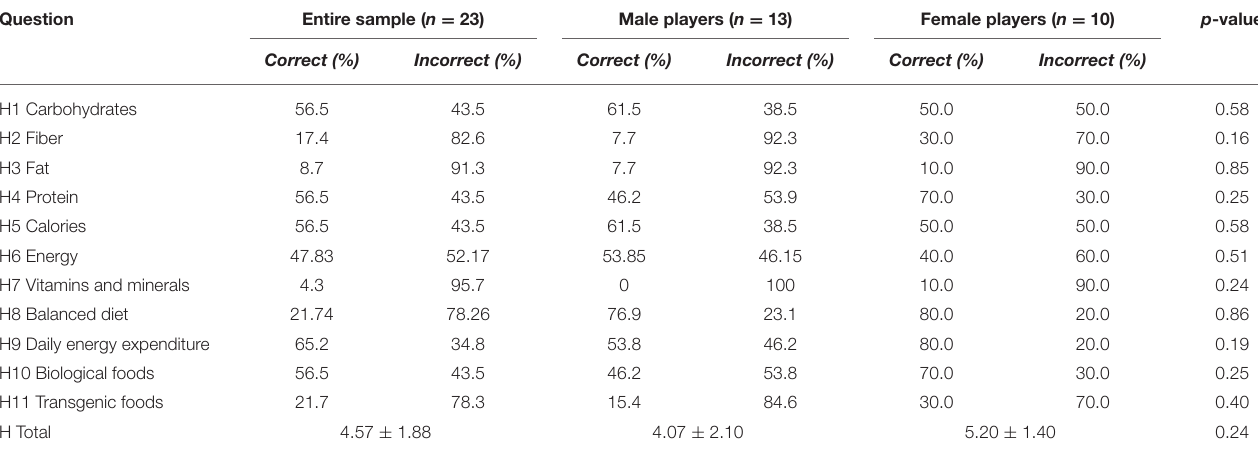
TABLE 4 | Comparisons in nutritional knowledge between elite, male and female, U-14 basketball players.